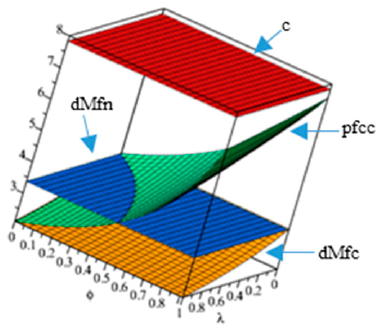
Figure 6. Effects of fairness concerns and profit-sharing on service level.